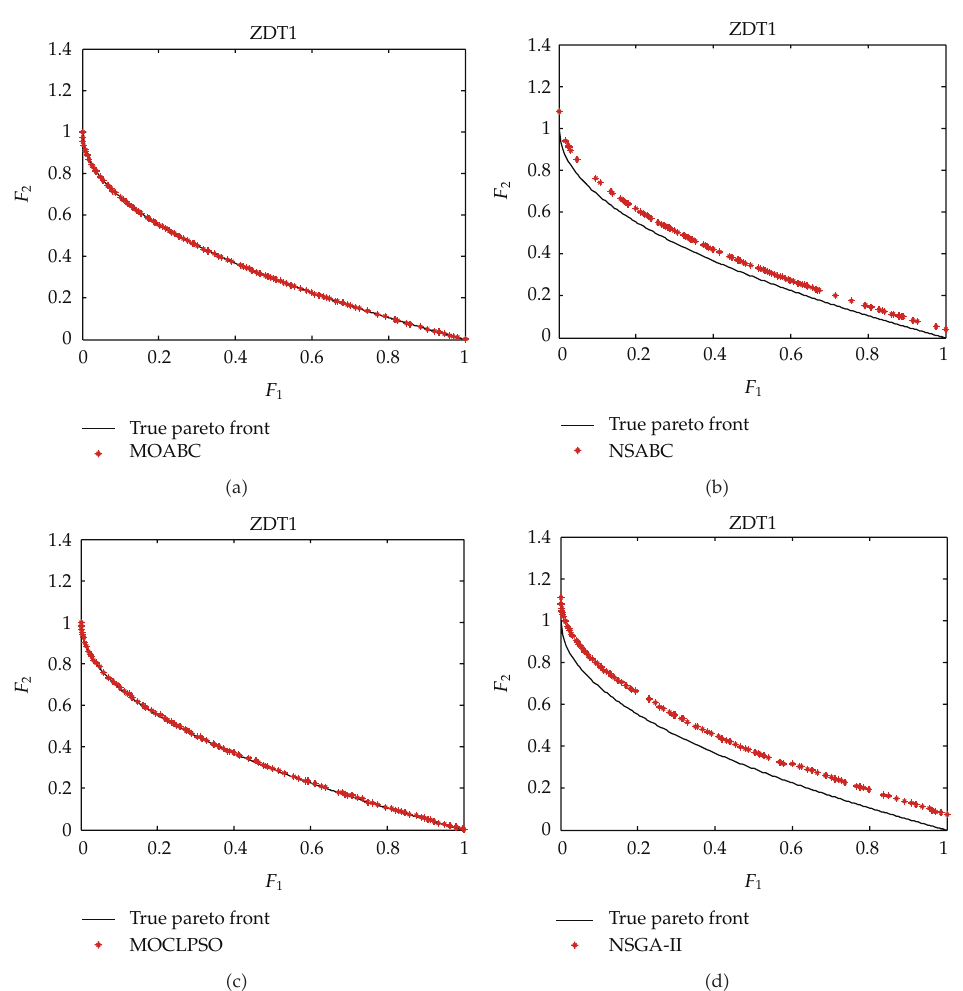
Figure 8: Pareto fronts obtained by NSABC, MOABC, MOCLPSO, and NSGA-II on ZDT1 after 20000 FEs.